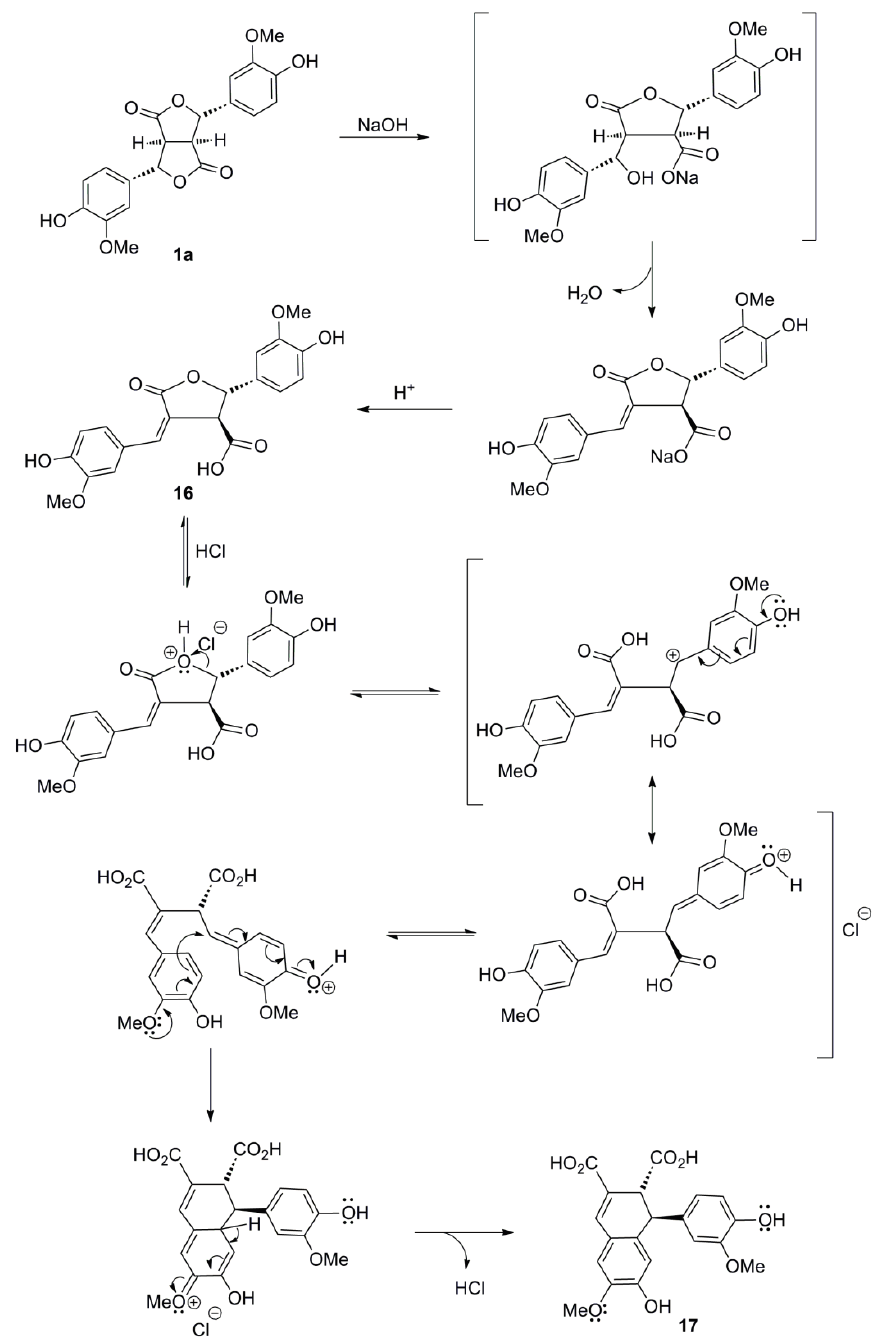
Scheme 13. Plausible mechanisms for the conversion of the dilactone 1a to arylnaphtalene 17 on treatment with NaOH first and then